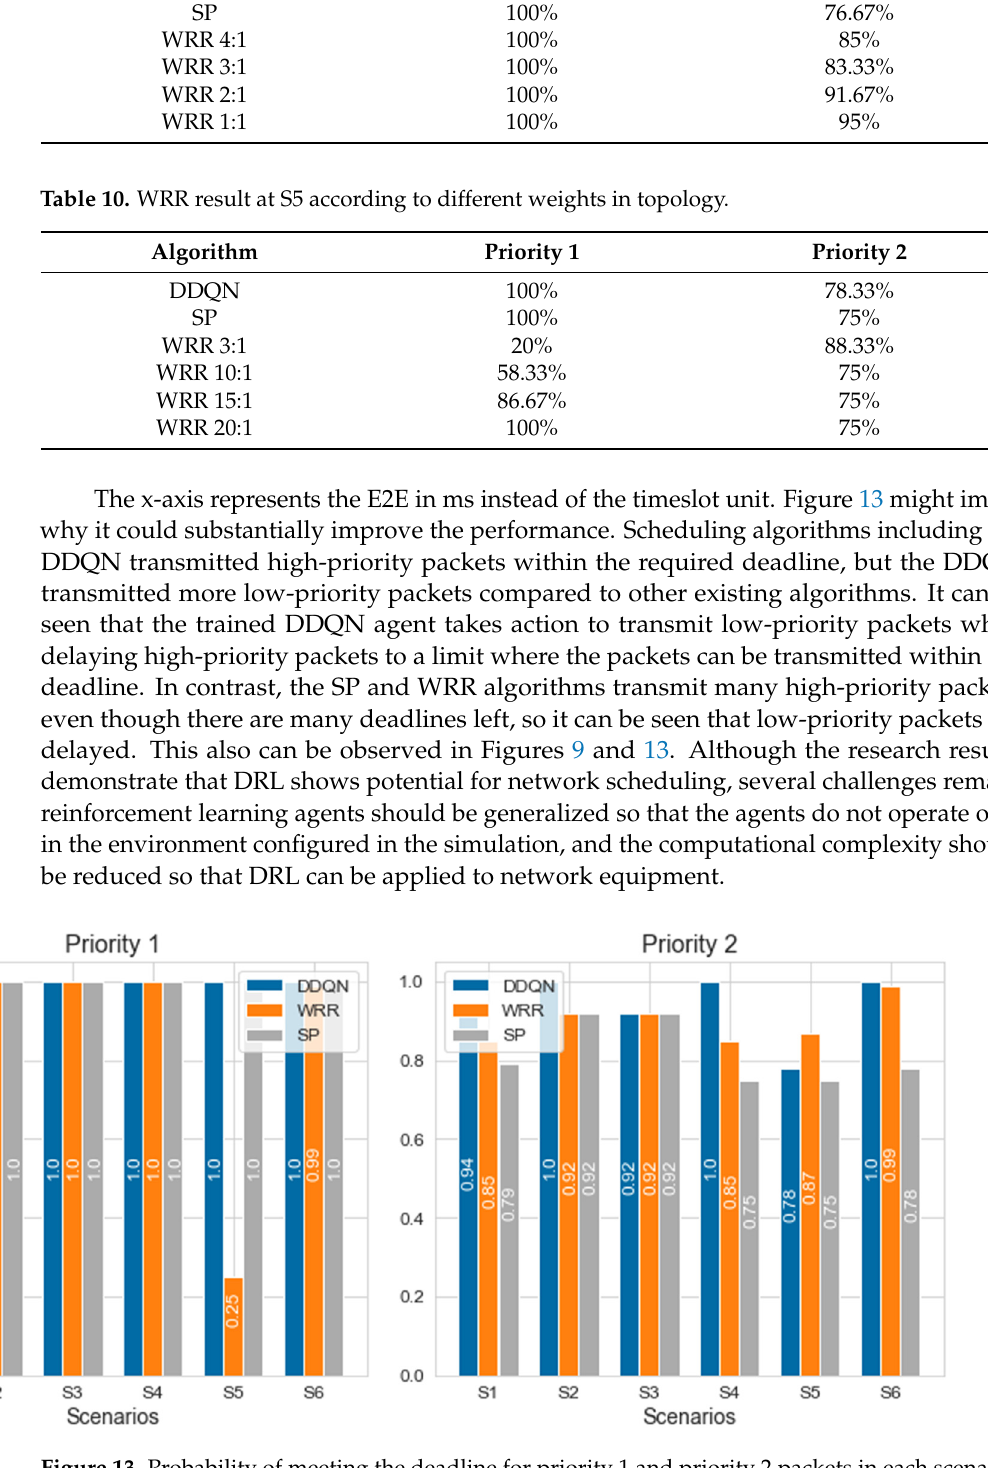
Figure 13. Probability of meeting the deadline for priority 1 and priority 2 packets in each sce- nario. Table 11. Inference time of the DDQN simulation and table look-up method in each scenario.